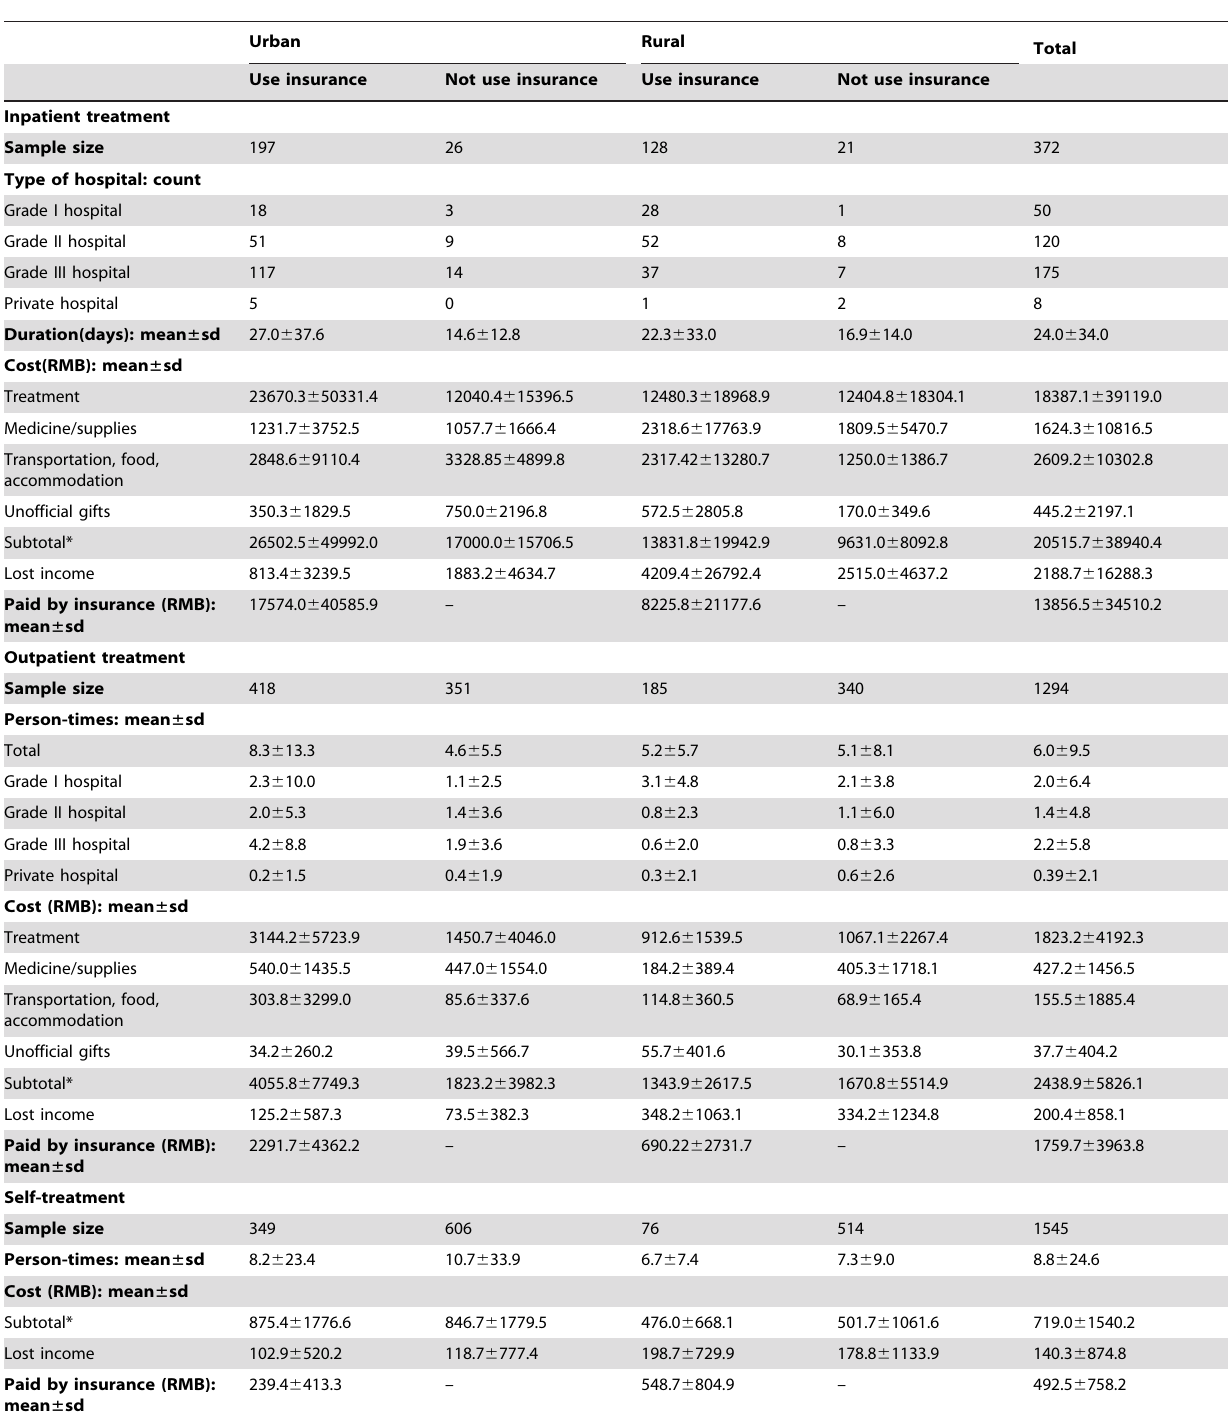
Table 2. Summary statistics for subgroups in different areas and with different insurance usage status.